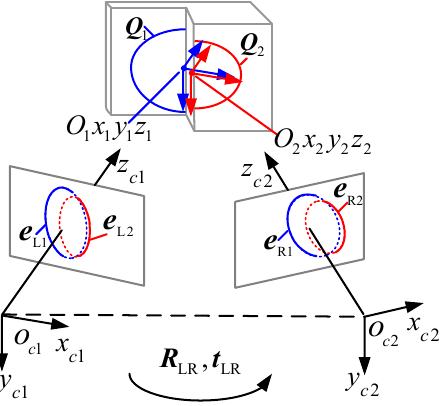
Figure 2. Calibration process of the binocular stereo vision sensor.